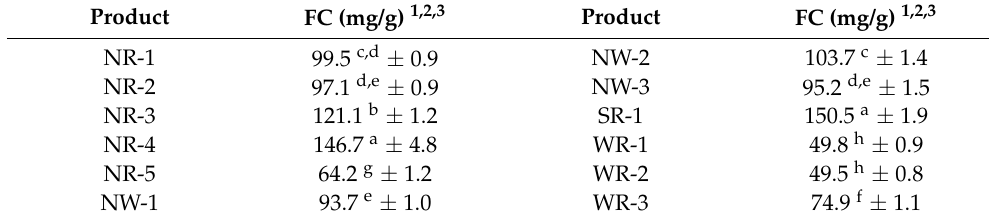
Table 3. Folin–Ciocalteu (FC) reducing capacity for extracts of Z. officinale